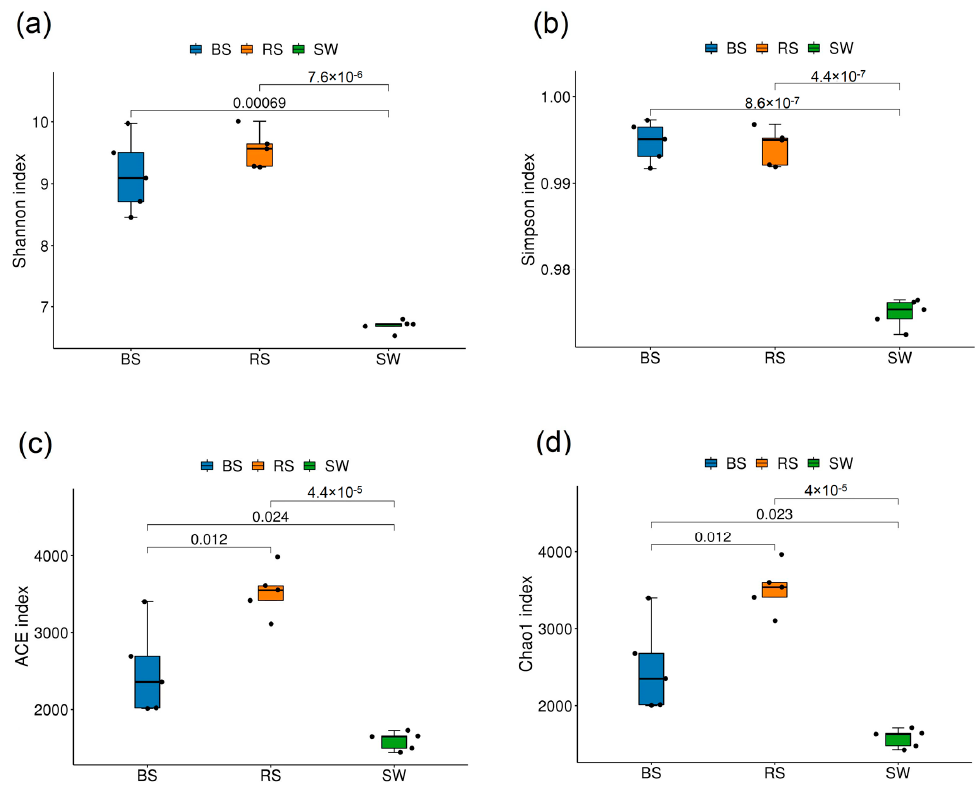
Figure 1. Alpha diversity of bacterial communities. RS: the seagrass rhizosphere soil samples; BS: sediment samples; SW: seawater samples. ( a ): Shannon index; ( b ): Simpson index; ( c ): ACE index; ( d ): Chao1 index. Di ff erent colored squares represent di ff erent groups. Statistical analysis was per- formed using the student’s t -test.